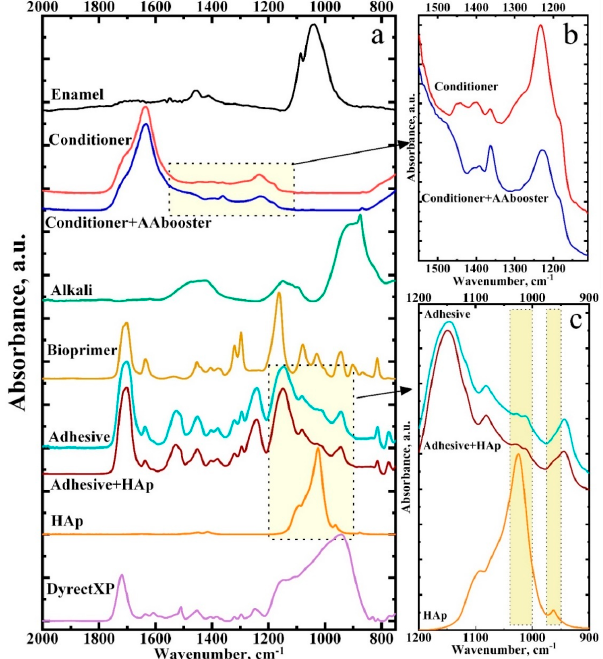
Figure 3. Typical FTIR spectra of the specimens studied in this work. ( a )—spectra for the healthy enamel, DyractXP dental compomer material, the conditioner including the amino acid booster, bioprimer, calcium alkali, original and modified BisGMA-based adhesive, and the nanocrystalline carbonate-substituted calcium hydroxyapatite; ( b )—FTIR spectra in the region of the most pro- nounced transformations of the vibrational modes for conditioner and conditioner including the amino acid booster; ( c )—FTIR spectra in the region of the most pronounced transformations of the vibrational modes for HAp, BisGMA-based adhesive and modified BisGMA-based adhesive.